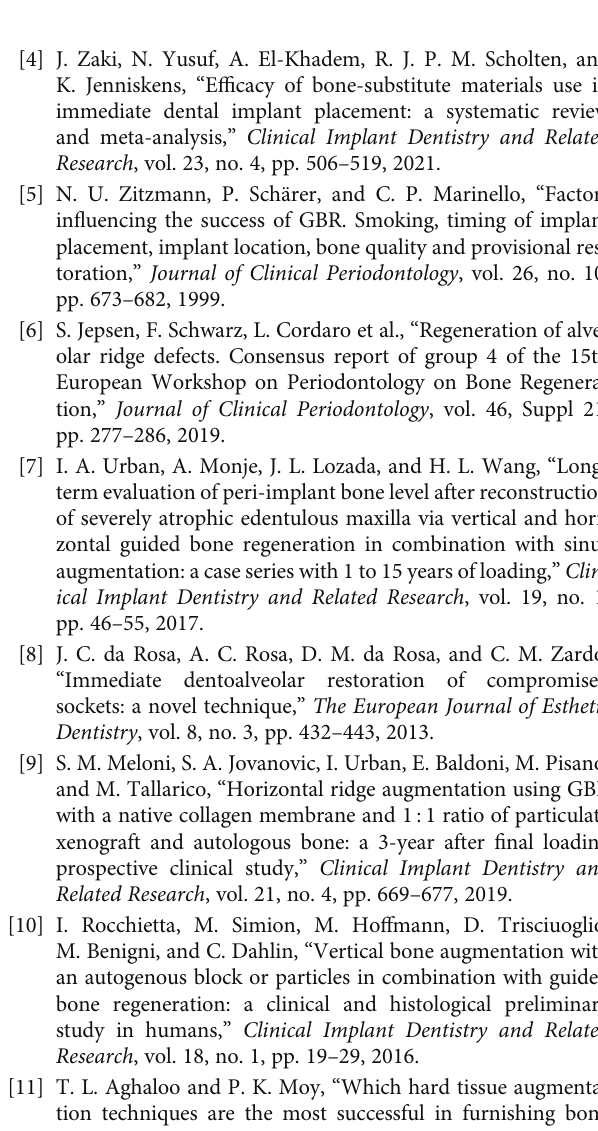
Figure 18: Periosteal invagination into the cancellous bone (blue, periosteum; yellow, functional periosteal layer; red, lamellar bone). Mallory ’ s trichome stain, ×